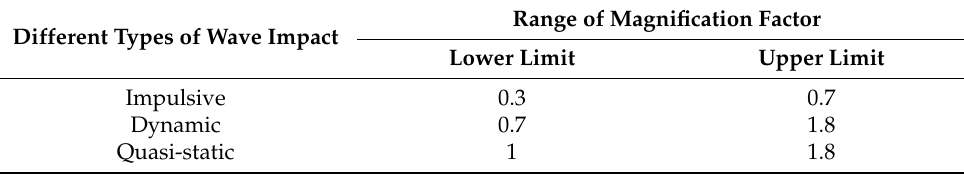
Table 6. Ranges of magnification factor for different wave impact types